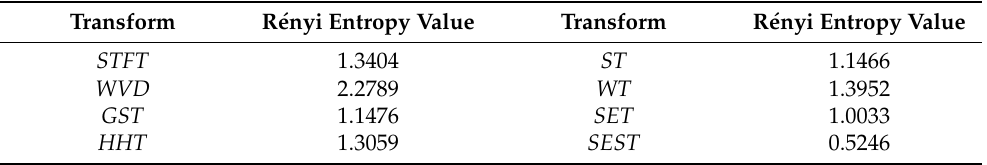
Table 3. R é nyi entropy evaluation results of rotor vibration fault